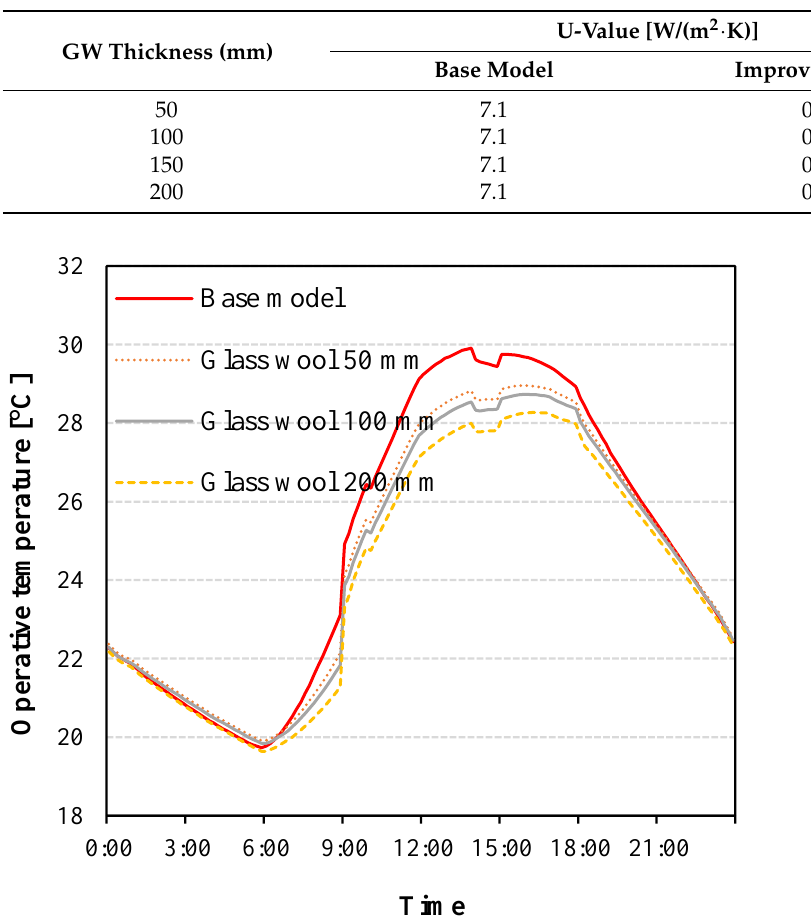
Table 9. Zinc roof insulation fabricated of glass wood (GW) and their thermal properties.